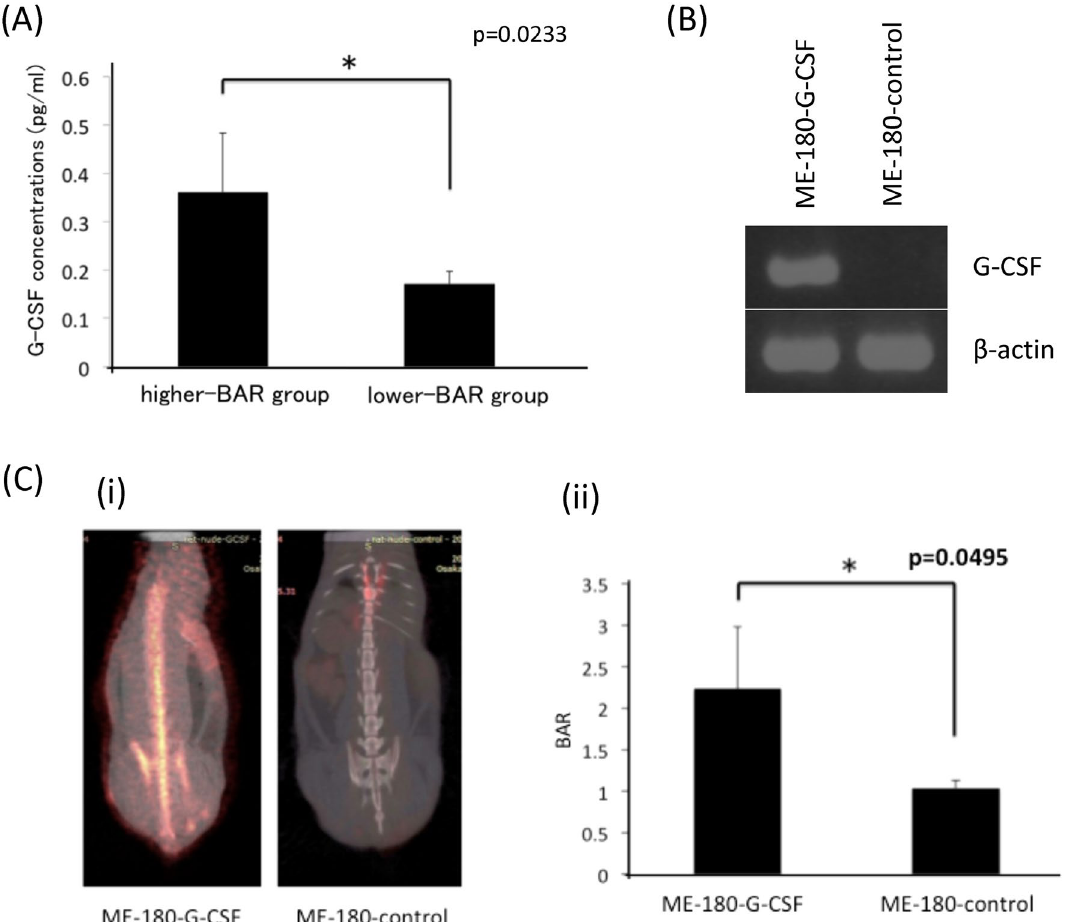
Figure 2. Tumor-derived G-CSF as a stimulator of BM FDG-uptake. ( A ) Correlation between and BAR and serum G-CSF levels in patients with cervical cancer. G-CSF concentrations in the serum of patients in higher and lower-BAR group of patients with cervical cancer were determined by ELISA. ( B ) Agarose gel electrophoresis of RT-PCR products for the expressions of G-CSF mRNA in ME-180-G-CSF or ME180-control cells. G-CSF and β-actin mRNA levels of ME-180 cells that had been incubated in the presence of 10% of FBS were assessed by RT-PCR. Full-length gels are presented in Supplemental Fig. 6A. ( C ) FDG-uptake in rat model of G-CSF-expressing cervical cancer. (i) Representative PET images obtained from rats bearing cervical cancer cells. (ii) The effect of tumor-derived G-CSF on the BM FDG-uptake in cervical cancer model